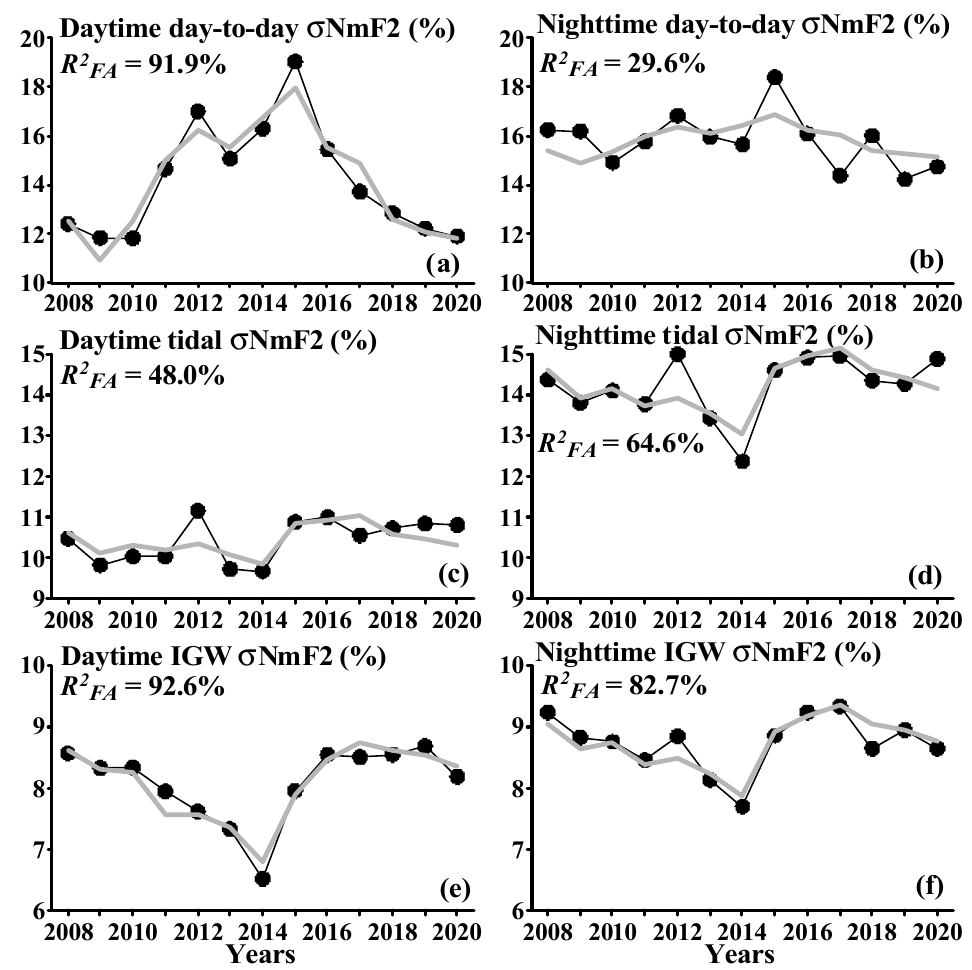
Figure 5. Year-to-year variations in σ NmF2 (black circle line) and their approximation by the multiple regression on F10.7 and Ap (grey) for the daytime ( left ) and nighttime ( right ). The day-to-day ( a , b ), tidal ( c , d ), and IGW ( e , f ) variability are presented from top to bottom. Table 1. Coefficients of multiple regression of σ NmF2 on F10.7 and Ap ( σ 0 , σ F , σ A ) and coefficients of determination for multiple (R 2 FA ) and simple regressions (R 2 F , R 2 A